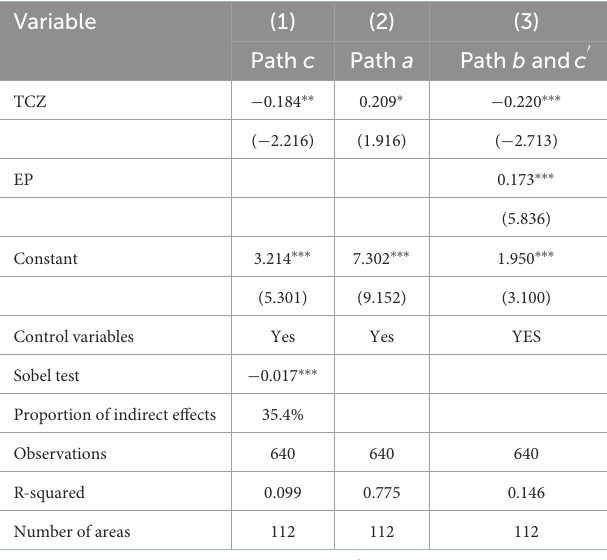
TABLE 6 Results of mechanism